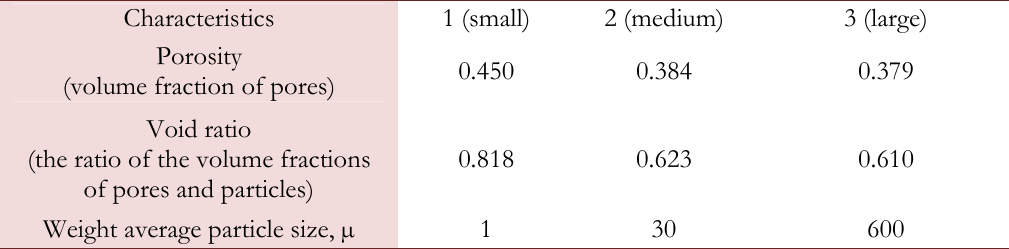
Table 1: Characteristics fractions of silica.